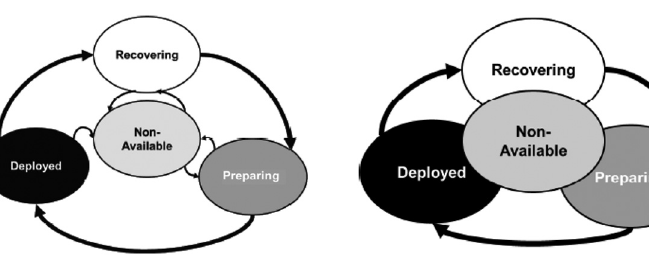
Figure 4. Three-force package model (left) and three- force package model accounting for changeover and transit time